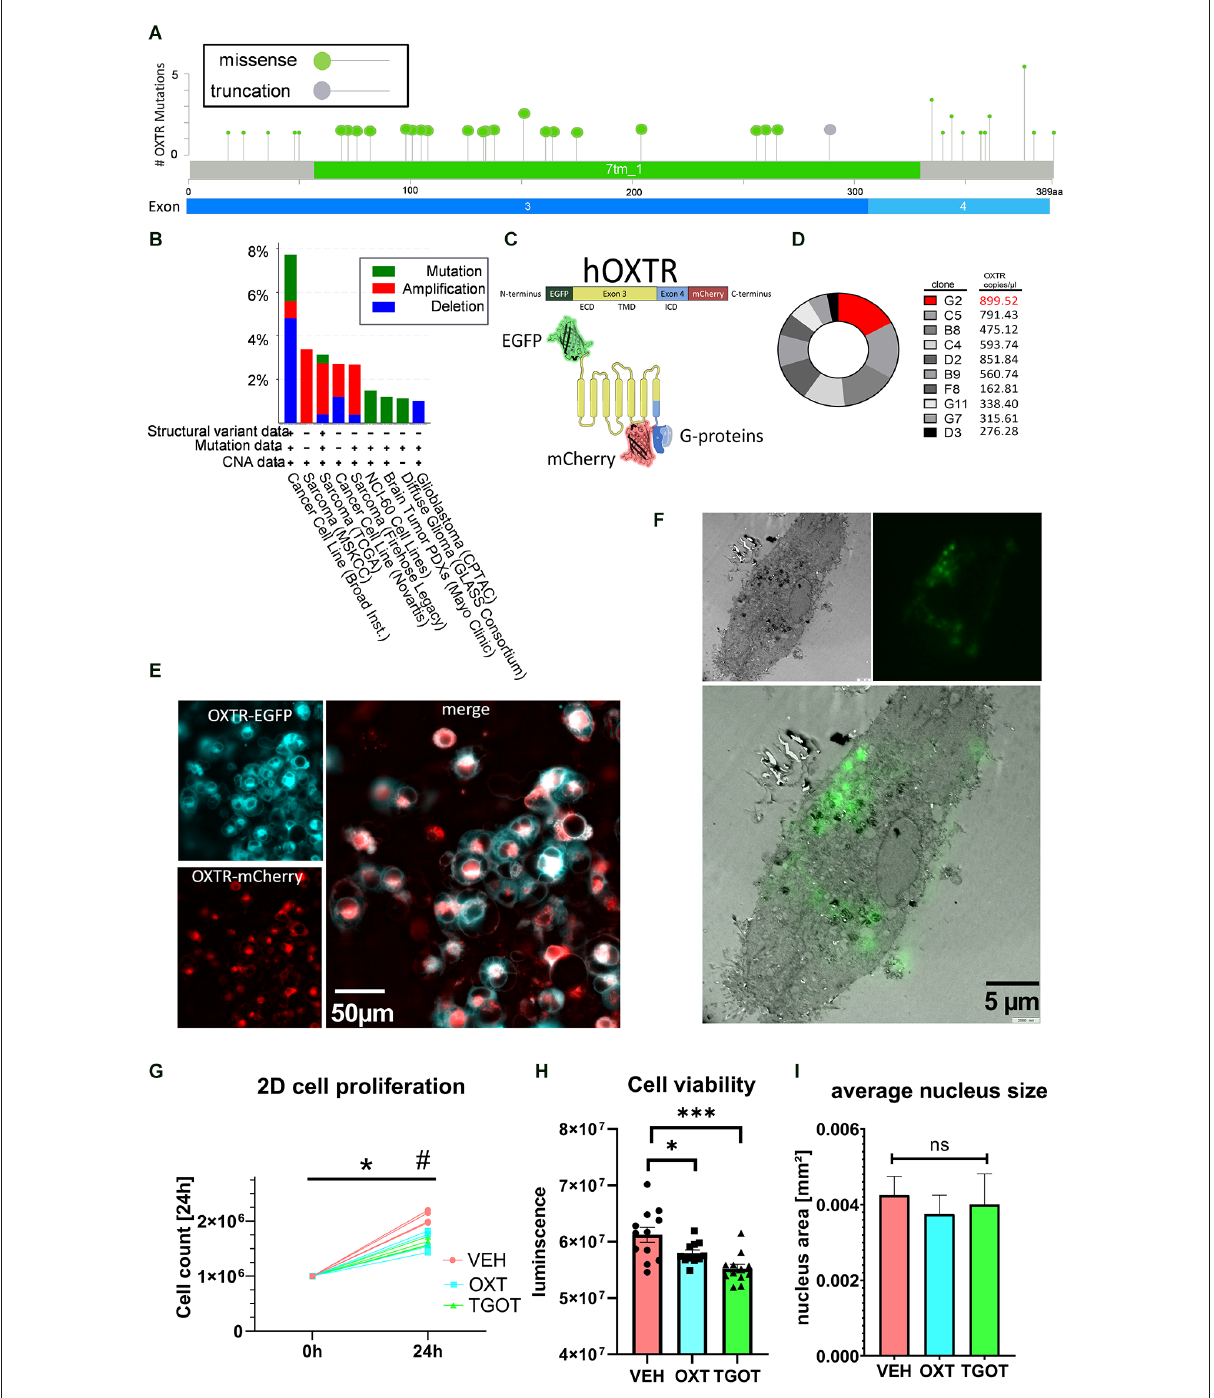
FIGURE1 Establishment of labeled OXTR-overexpressing liposarcoma cells MLS-G2. (A) Localization of exonic sarcoma/carcinoma-related missense mutations or truncation within the human OXTR gene. Twenty missense mutations are localized in the transmembrane domain (Exon 3), and 10 missense mutations are localized in the intracellularG-protein-binding C-terminal domain. Source: cBioportal, data extracted from 23,945 samples from 31 different studies. (B) cBioPortal-extracted data on the occurrence of OXTR variants from different sources. Cancer cell lines and sarcoma tissue are represented with 8% and 3%, respectively, indicating a minor but consistent basis for the use of the liposarcoma cell line MLS-402 for OXTR overexpression. (C) Schematic representation ofthe labeled human OXTR with N-terminal EGFPand C-terminal mCherry. Exon 3 encodes the extracellular domain (ECD) and the transmembrane domain (TMB), whereas exon 4 encodes most of the intracellular